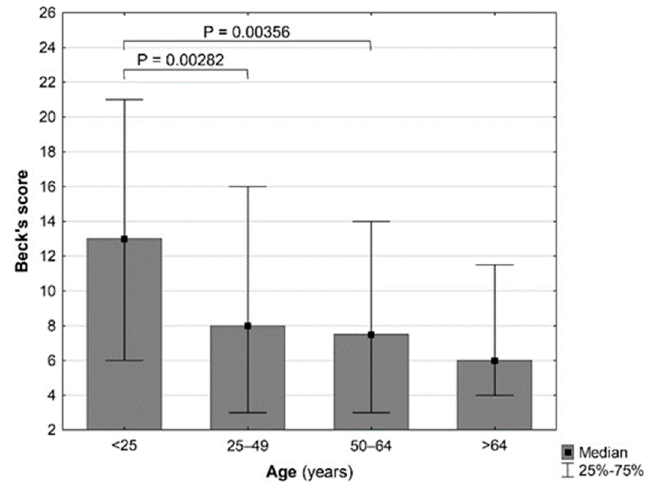
Figure 2. Differences in scoring according to the Beck’s scale in identified age ranges. Statistically significant differences are marked ( P < 0.05).